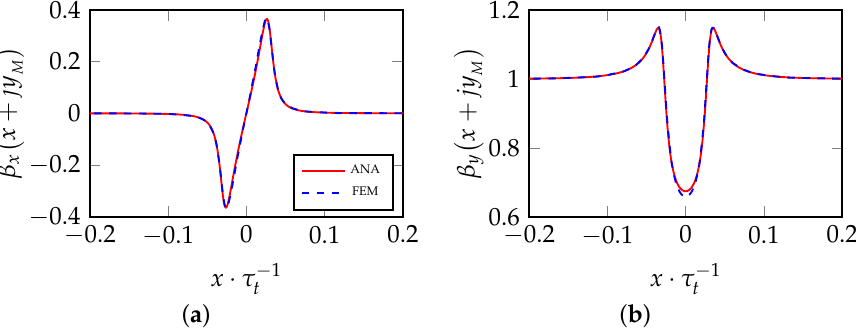
Figure 9. Analytical and FEM no-load flux density p.u. ( a ) normal and ( b ) tangential component on the middle mechanical air-gap line at y e = y